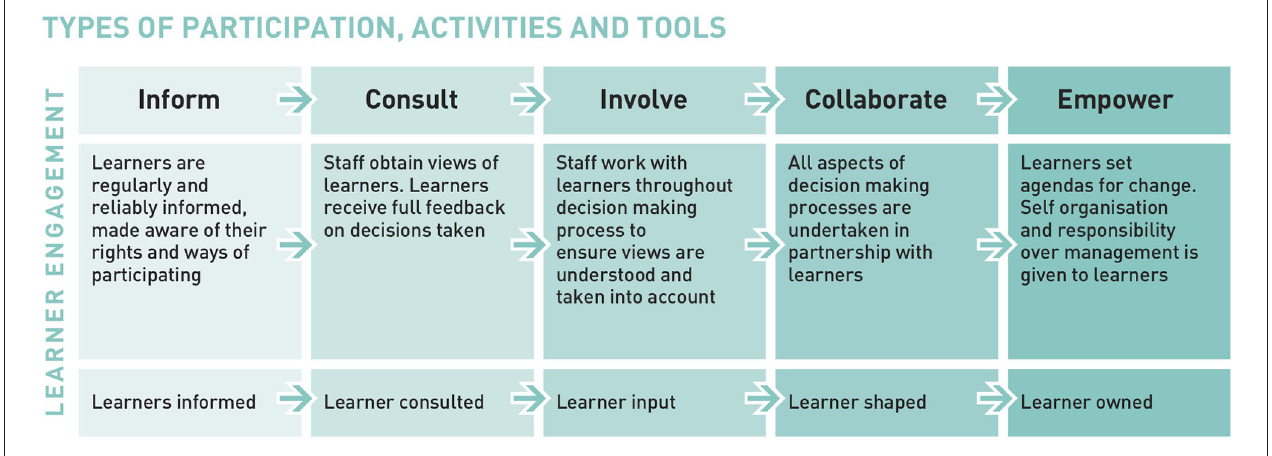
FIGURE 1 | Levels of learner voice participation [partial figure] (Rudd et al., 2006, p.